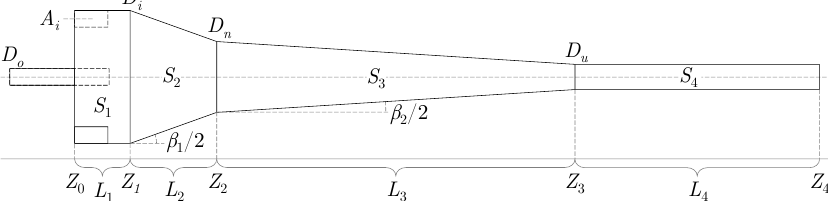
Figure 4. Simplified geometry of a single Colman/Thew-type hydrocyclone liner, where S is hydrocyclone segment, L is segment length, Z is axial position, D is inner diameter, A i is inlet area, and β is cone